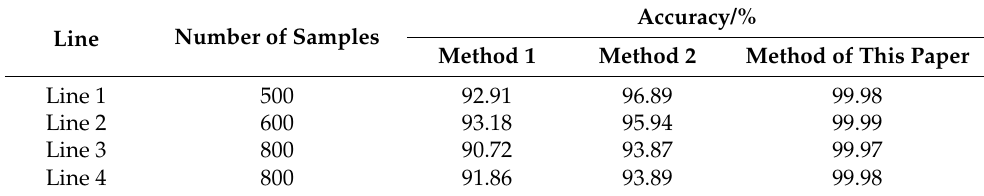
Table 4. Comparison of the noise immunity of the different methods.